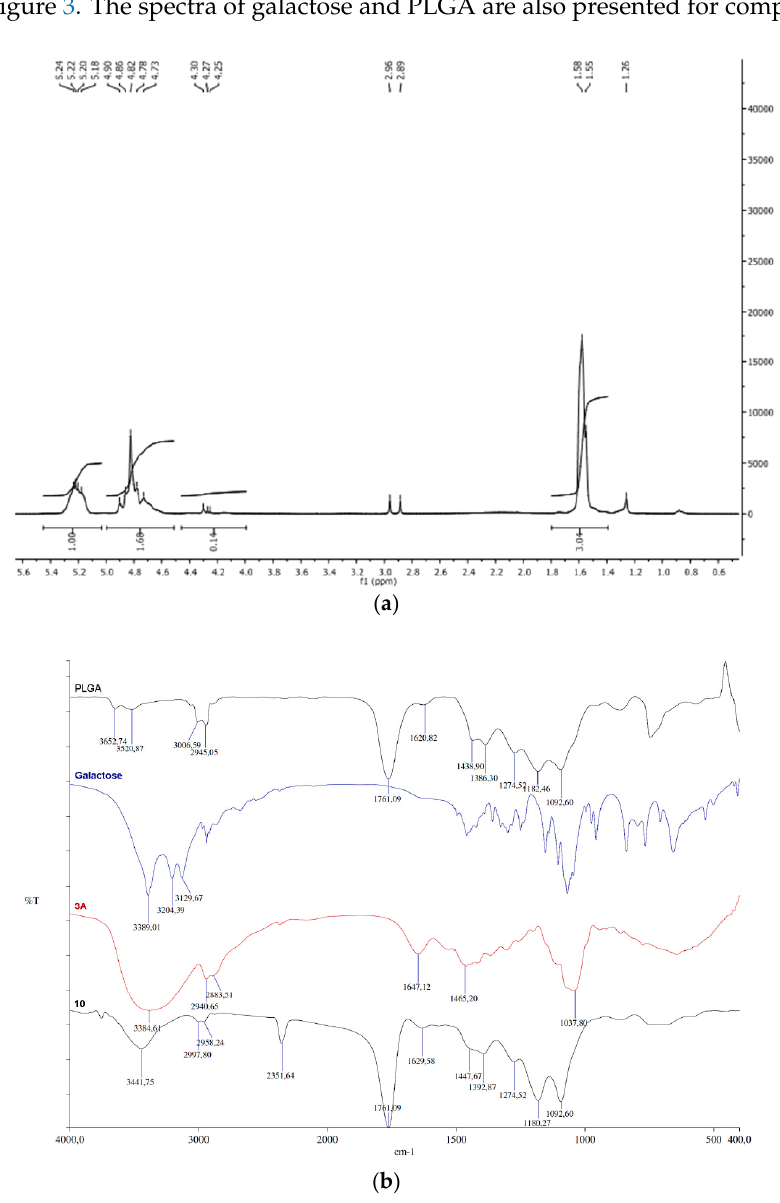
Figure 3. ( a ) 1 H NMR spectrum (D 2 O) of bis(1- O -ethyl- β -D-galactopyranosyl)amine-PLGA conjugate, PLGA-di-GAL, 10 . ( b ) FTIR spectra of PLGA, galactose, bis(1- O -ethyl- β -D-galactopyranosyl)amine ( 3a ) and PLGA-di-GAL ( 10 ).